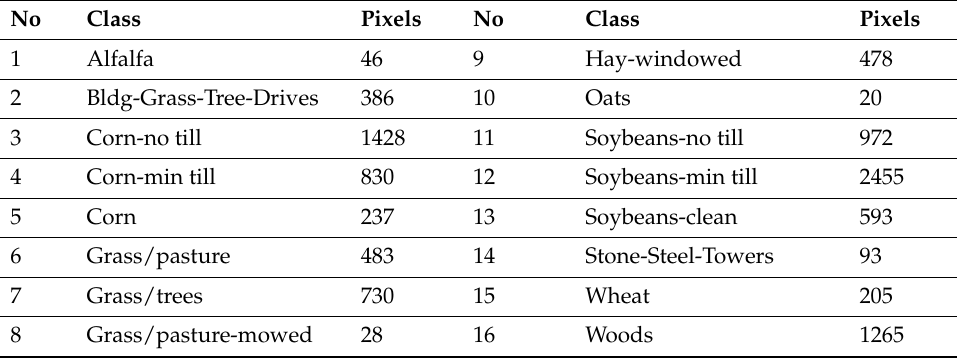
Table 2. Type of classes and their respective labeled pixels number in the Indian Pines